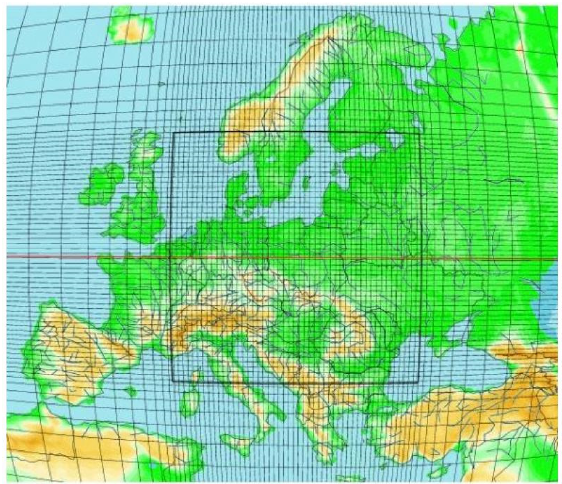
Figure 3. Core grid with a uniform resolution of 0.125 deg (red line—numerical